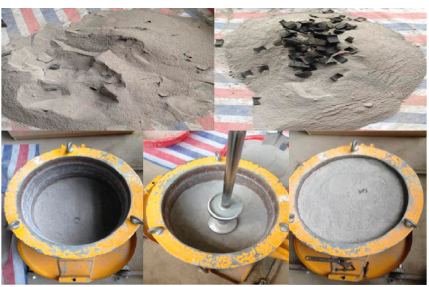
Figure 3: Sample preparation